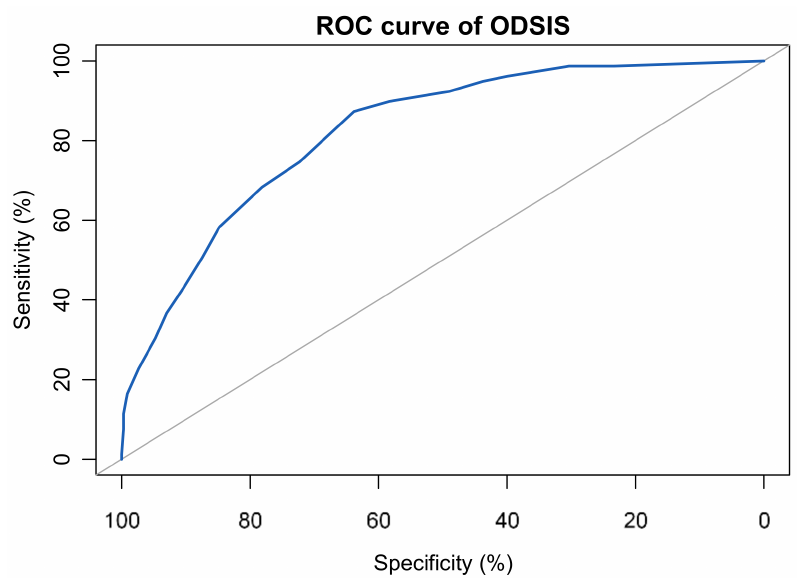
Figure 4. ROC curve of the ODSIS (Sample 4, n =